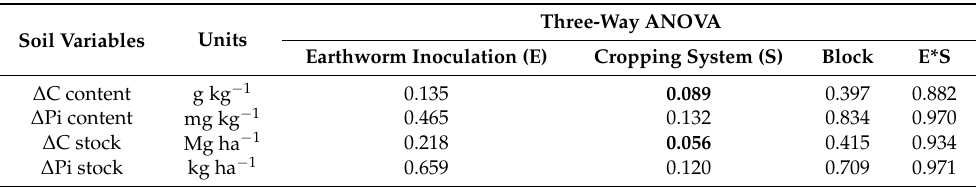
Table 5. Three-way ANOVA statistics ( p -values) of changes of soil properties with time (2013 to 2016). Legend: see Table 2. Significant p -values are in